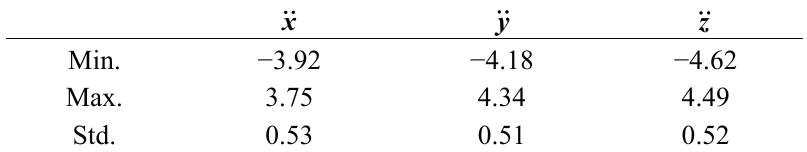
Table 2. Statistical characteristics of estimated accelerations (unit: m/s 2 ).